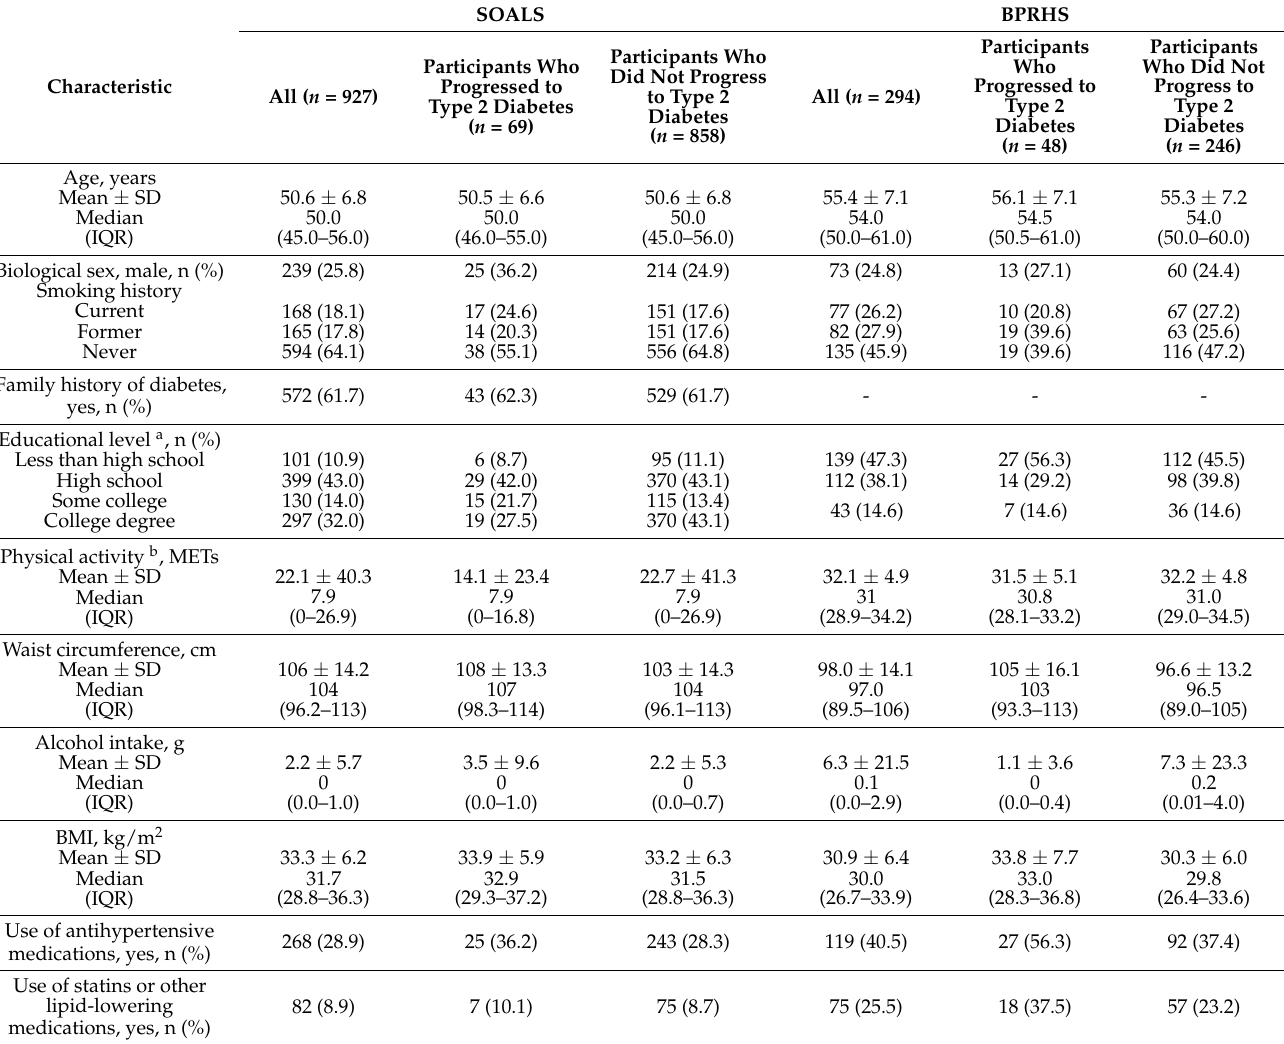
Table 1. Distribution of SOALS and BPRHS participant characteristics, among all, and by type 2 diabetes progression